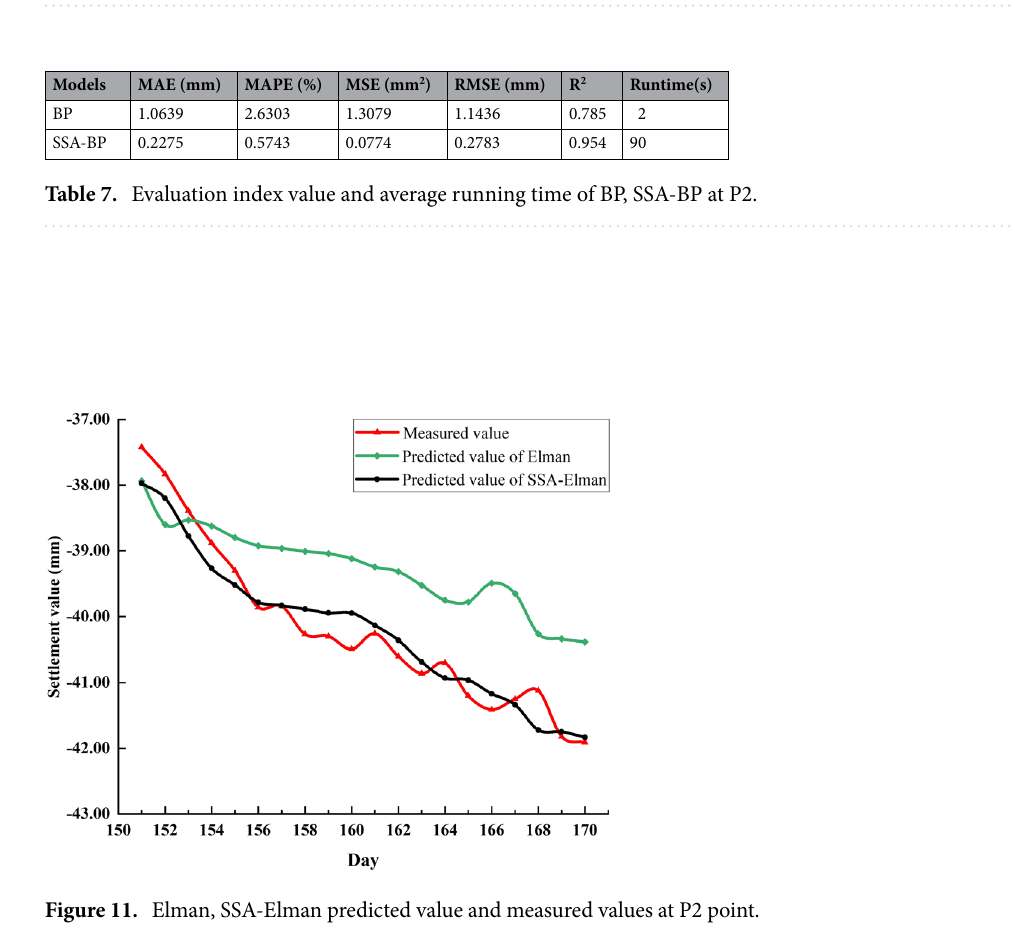
Table 6. Predicted value variance of BP and SSA-BP at P2.